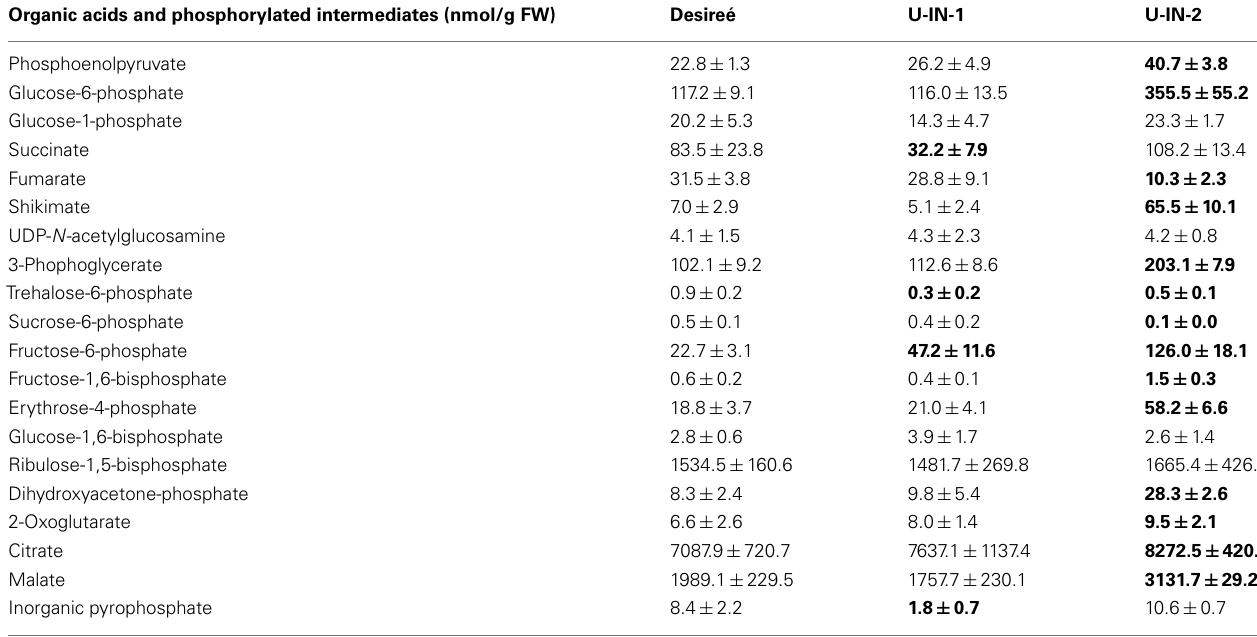
TableA1 | Phosphorylated intermediates and organic acid content of the different genotypes. Organic acids and phosphorylated intermediates (nmol/g FW)